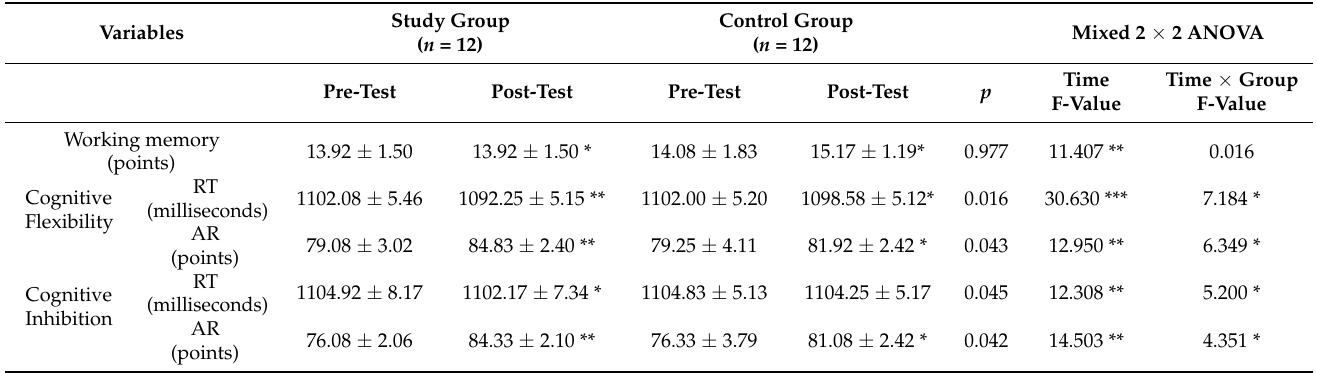
Table 3. The results of executive function and reaction time within and between-group